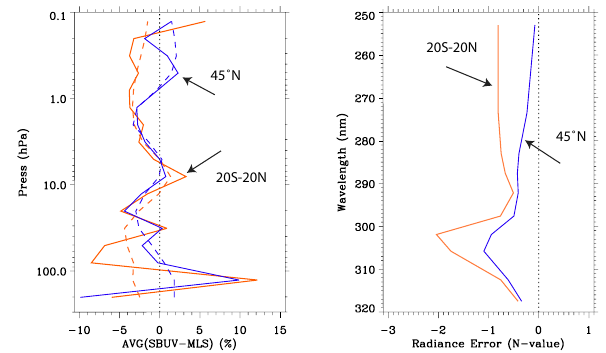
Figure 15. Left panel shows the bias between NOAA-17/SBUV and Aura/MLS derived Fig. 15. Left panel shows the bias between NOAA-17/SBUV and by averaging 6 years of data (2005-2010). The solid lines show unsmoothed data, the Aura/MLS derived by averaging 6yr of data (2005–2010). The solid dashed lines smoothed data. The smoothed differences are less than 5% at all altitudes. Variations in unsmoothed data near 100 hPa are caused by systematic differences lines show unsmoothed data, the dashed lines smoothed data. The between MLS and ozonesonde data that were used to construct SBUV a priori . The bias smoothed differences are less than 5% at all altitudes. Variations at higher altitudes could be caused by diurnal effects. The right panel shows the implied error in SBUV radiances assuming MLS data have no errors. The magnitude and latitude in unsmoothed data near 100hPa are caused by systematic differ- Fig. 14. Vertical profiles of the ratio between morning and af- dependence of errors at the longer wavelengths are larger than the uncertainty in SBUV ences between MLS and ozonesonde data that were used to con- measurements implying that the some of SBUV/MLS bias at lower altitudes may be MLS ternoon SBUV measurements. NOAA-16/17 data are from 2002– Figure 14. Vertical profiles of the ratio between morning and afternoon SBUV error. struct SBUV a priori. The bias at higher altitudes could be caused by measurements. NOAA-16/17 data are from 2002-2005 when NOAA-16 was in 2 pm 2005, when NOAA-16 was in 14:00 equator-crossing time (ECT) diurnal effects. The right panel shows the implied error in SBUV ra- equator-crossing-time (ECT) orbit and NOAA-17 in 10:30 am ECT, NOAA-17/18 data orbit and NOAA-17 in 10:30 ECT; NOAA-17/18 data are from are from 2005-2009, when NOAA-18 was in 1:30 pm ECT. Error bars indicate the diances assuming MLS data have no errors. The magnitude and lat- 2005–2009, when NOAA-18 was in 13:30 ECT. Error bars indi- √ standard error of the mean ( 𝜎 𝑁 ). The 2-3% ozone differences changing sign around itude dependence of errors at the longer wavelengths are larger than N) . The 2–3% ozone dif- cate the standard error of the mean ( σ/ ~3hPa are qualitatively consistent with the diurnal variations measured by the NDACC the uncertainty in SBUV measurements, implying that the some of microwave radiometer (MWR) at Mauna Loa (Alan Parrish, private communication). ferences changing sign around ∼ 3hPa are qualitatively consistent SBUV/MLS bias at lower altitudes may be MLS with the diurnal variations measured by the NDACC microwave ra- diometer (MWR) at Mauna Loa (Alan Parrish, private communica- tion).